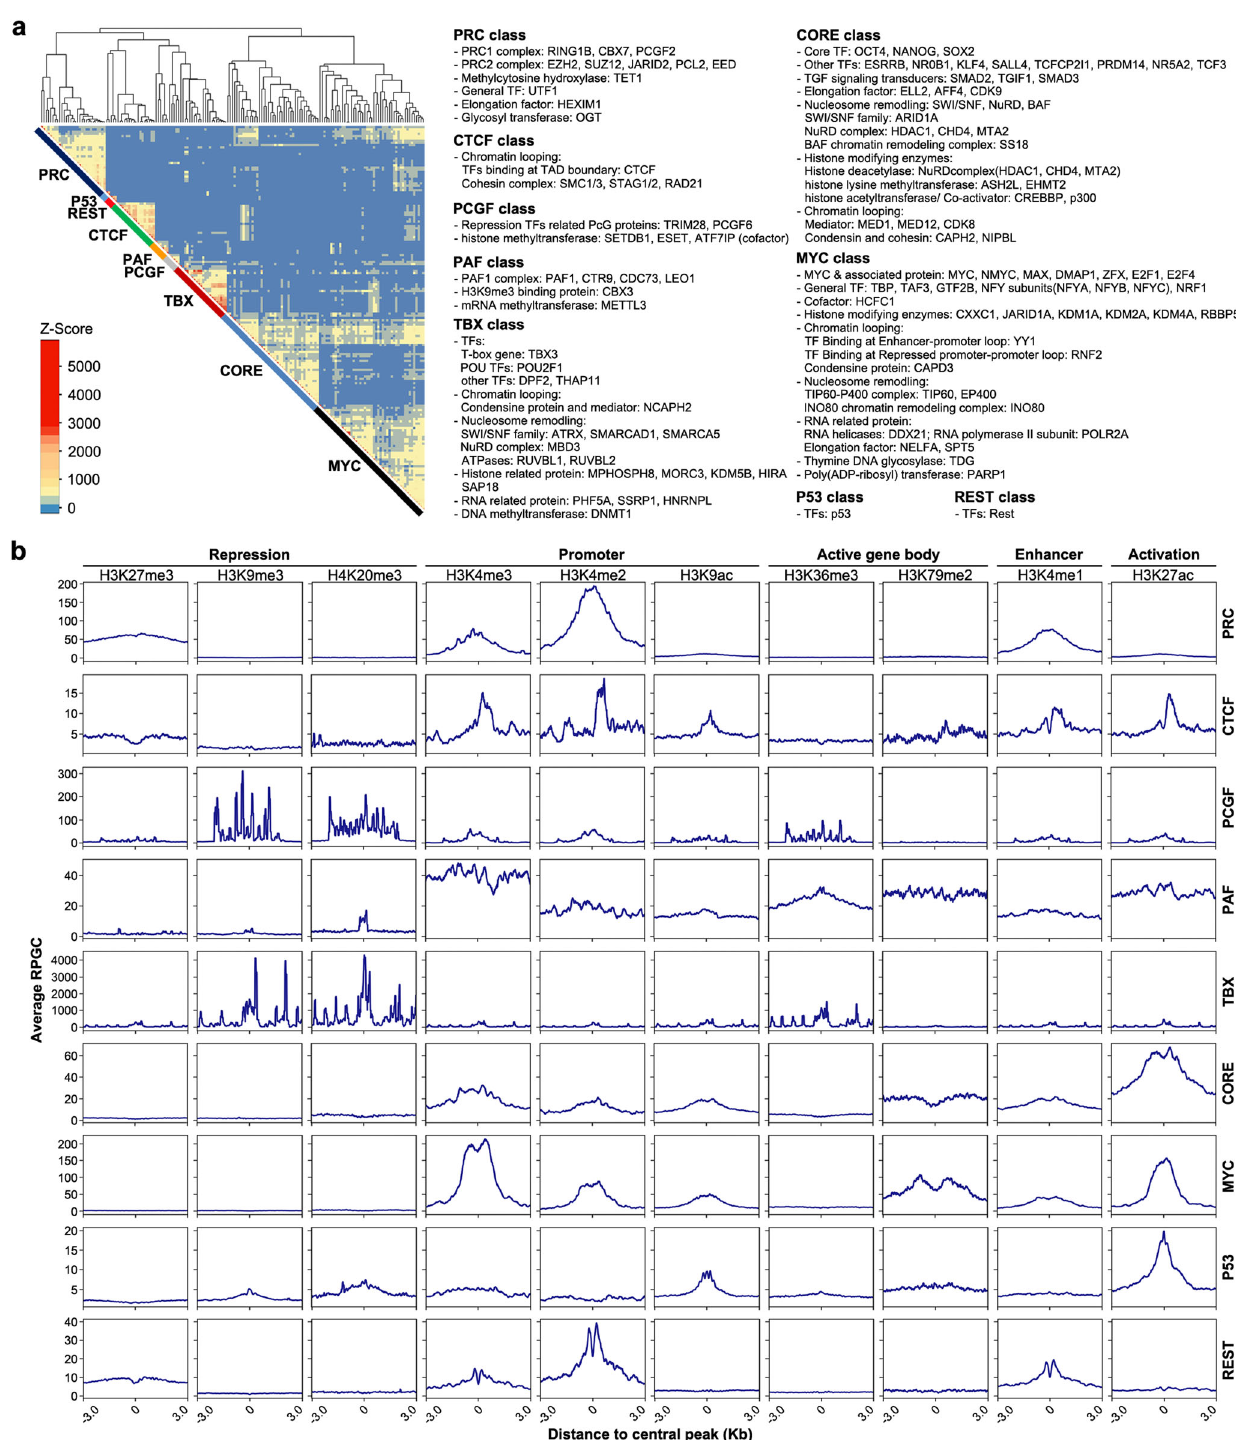
Fig. 5 Clustering the sub-classes in the PGRN and identifying their associated histone modi fi cation status. a Classi fi cations of sub-classes based on co- occupancy. Nine sub-classes were unsupervised hierarchical clusters based on Z-scores from 171 genes (total of 374 ChIP-seq data, see Methods section). All the sub-classes and their contents are shown on the right: PRC (12 genes, 29 experiments), CTCF (7 genes, 17 experiments), PCGF (5 genes, 5 experiments), PAF (6 genes, 6 experiments), TBX (20 genes, 21 experiments), CORE (32 genes, 41 experiments), MYC (43 genes, 47 experiments), P53 (single gene, 2 experiments) and REST (single gene, 3 experiments). b Histone modi fi cation status of the nine sub-classes. The average normalized read count of histone modi fi cation (y axis) within ±3 kb from the central peak of the sub-class (x axis) is plotted.